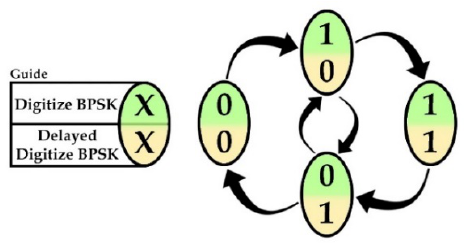
Figure 4. Possible states of data detector inputs.